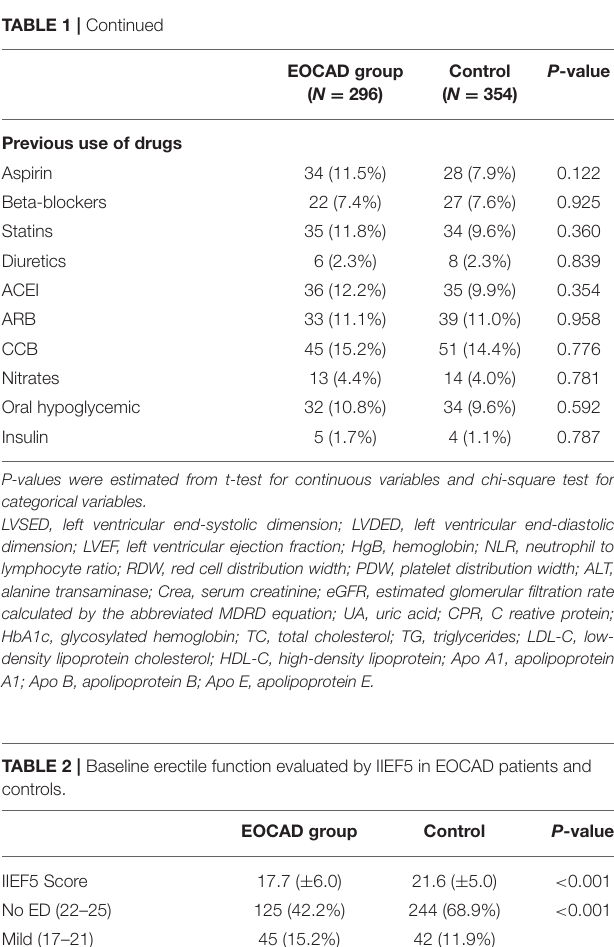
TABLE 1 | Baseline clinical characteristics of EOCAD patients and controls.